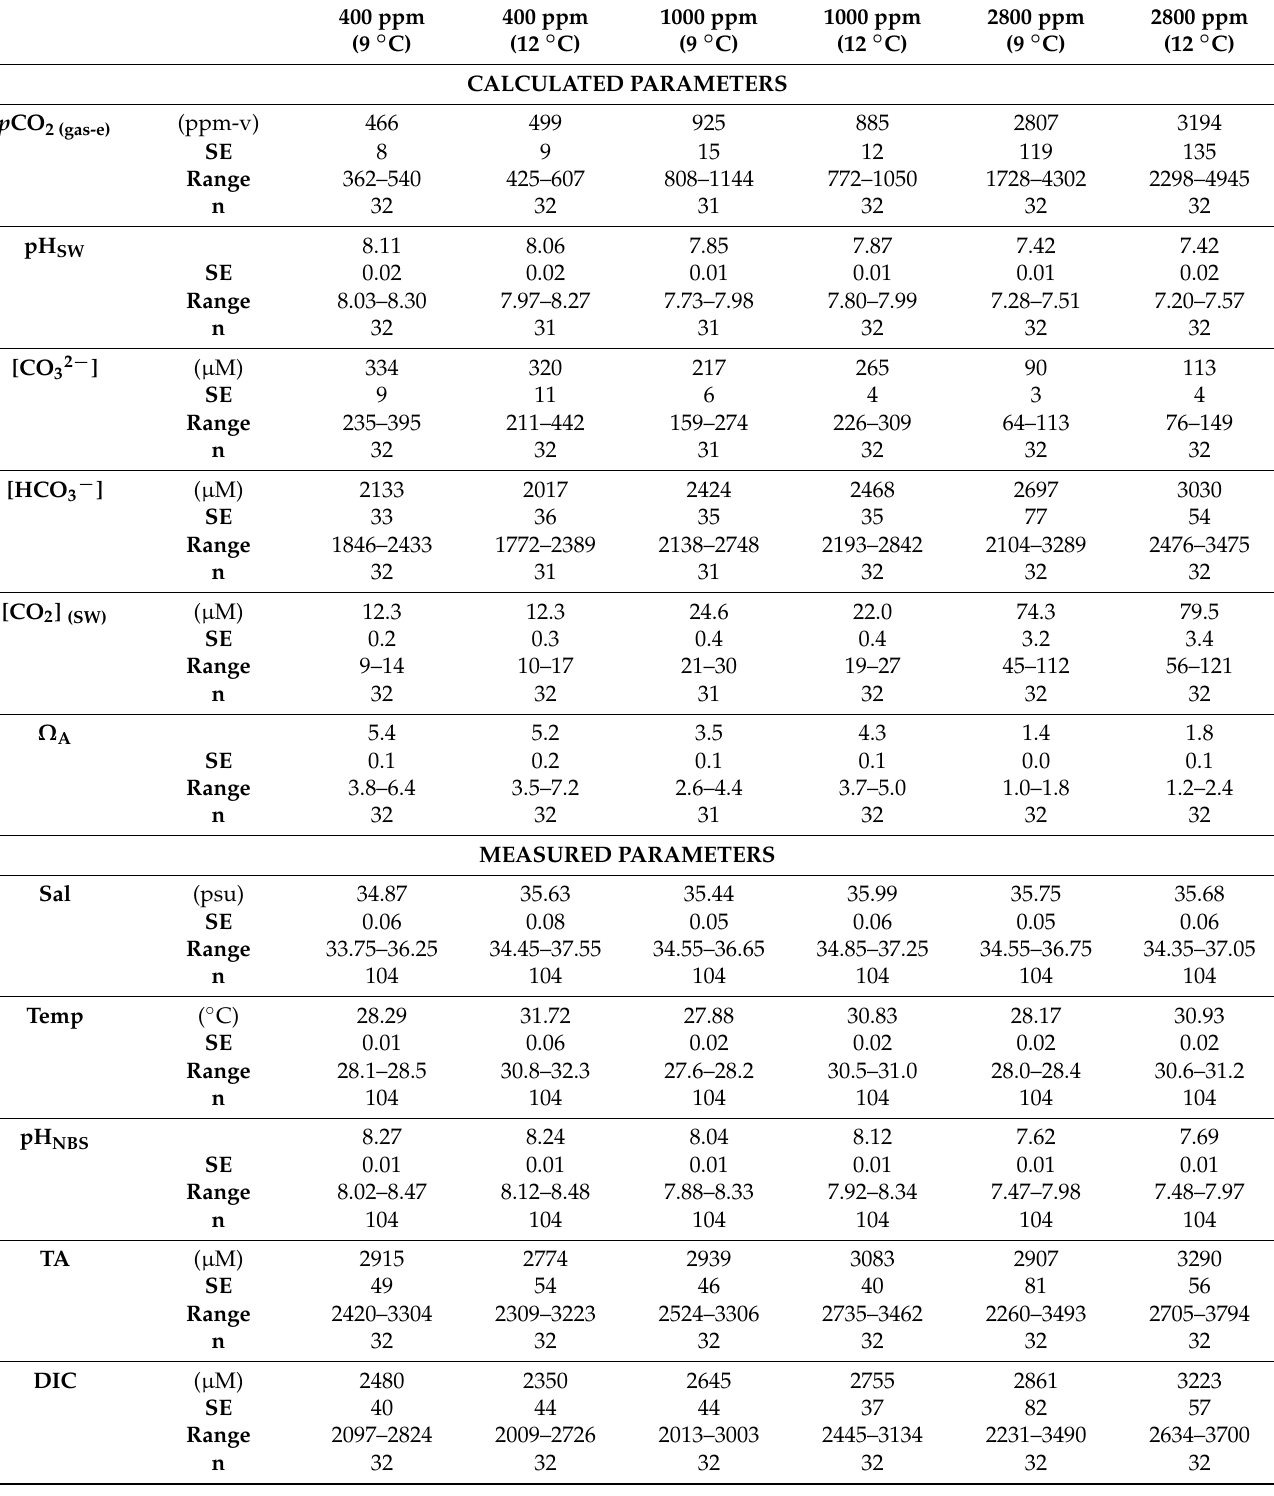
Table 1. Average calculated parameters for the tropical corals and all treatments: pCO 2 of the mixed gases in equilibrium with seawaters (pCO 2 (gas-e)), pH on seawater scale (pH SW ), carbonate ion concentration ([CO 32 − ]), bicarbonate ion concentration ([HCO 3 − ]), dissolved carbon dioxide ([CO 2 ] SW ), and aragonite saturation state ( Ω A ). Average measured parameters for all treatments: salinity (Sal), temperature (Temp), pH on NBS scale (pH NBS) , total alkalinity (TA), and dissolved inorganic carbon (DIC). ‘SE’ represents standard error and ‘n’ is the sample size. 400 ppm (9 ◦ C) CALCULATED